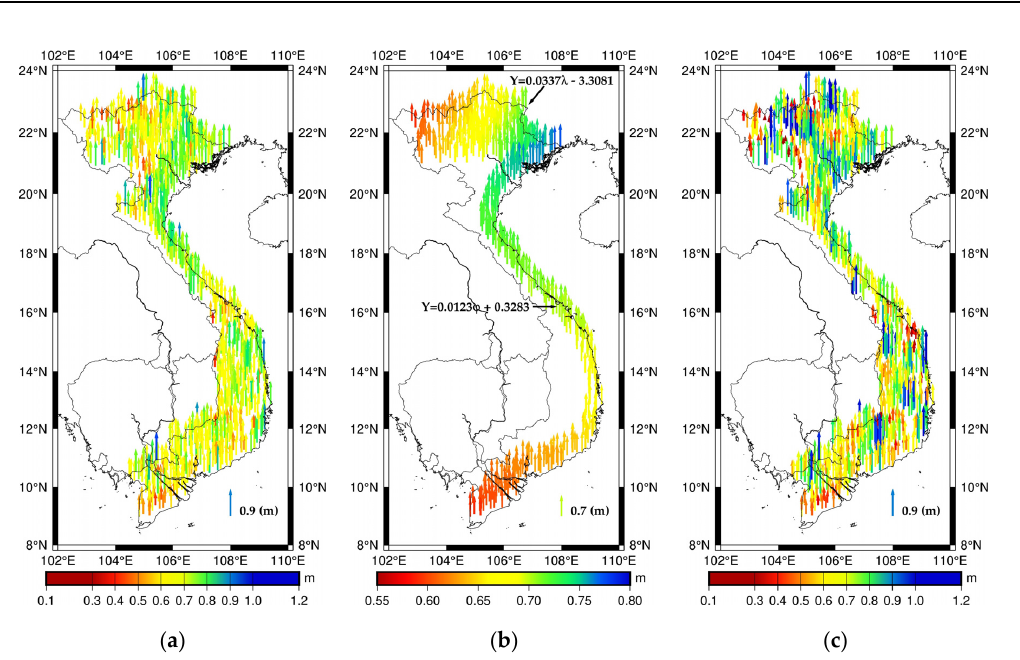
Figure 3. ( a ) Differences between GNSS/levelling data and GEOID_LSC; ( b ) Linear regression on the Figure 3. ( a ) Di ff erences between GNSS / levelling data and GEOID_LSC; ( b ) Linear regression on the differences of GNSS/levelling data and GEOID_LSC in northern (>21° in latitude) and near coast di ff erences of GNSS / levelling data and GEOID_LSC in northern ( > 21 ◦ in latitude) and near coast (points within 50 km from the coastline) and ( c ) Differences between GNSS/levelling data and (points within 50 km from the coastline) and ( c ) Di ff erences between GNSS / levelling data and DIR / EGM DIR/EGM (d/o 719) plus RTM effects. (d / o 719) plus RTM e ff